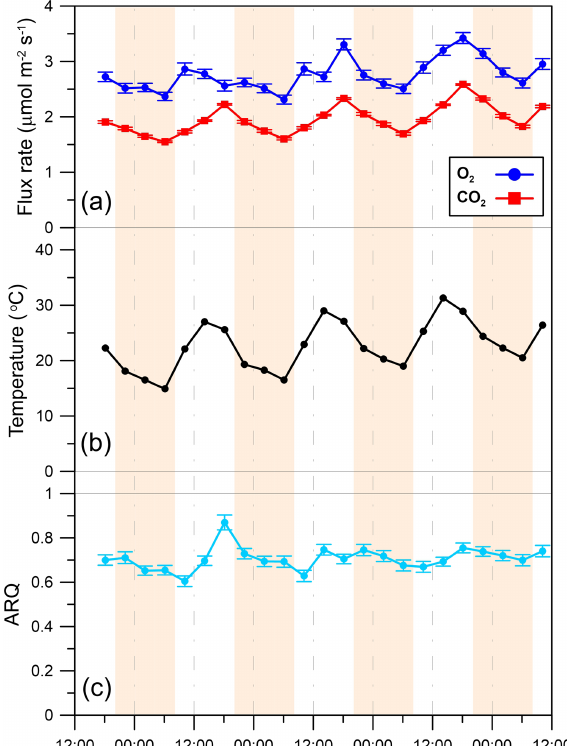
Figure 6. Diurnal patterns of (a) O 2 influx to the stem and CO 2 efflux from the stem, (b) chamber temperature, and (c) instanta- neous ARQ (ratio CO 2 efflux / O 2 influx for tree stems). Shaded ar- eas indicate night periods. Error bars are 95% confidence bounds. All data were obtained from a single M. domestica tree during 24– 28 April 2013 on the Hebrew University campus in Jerusalem, Is- rael.